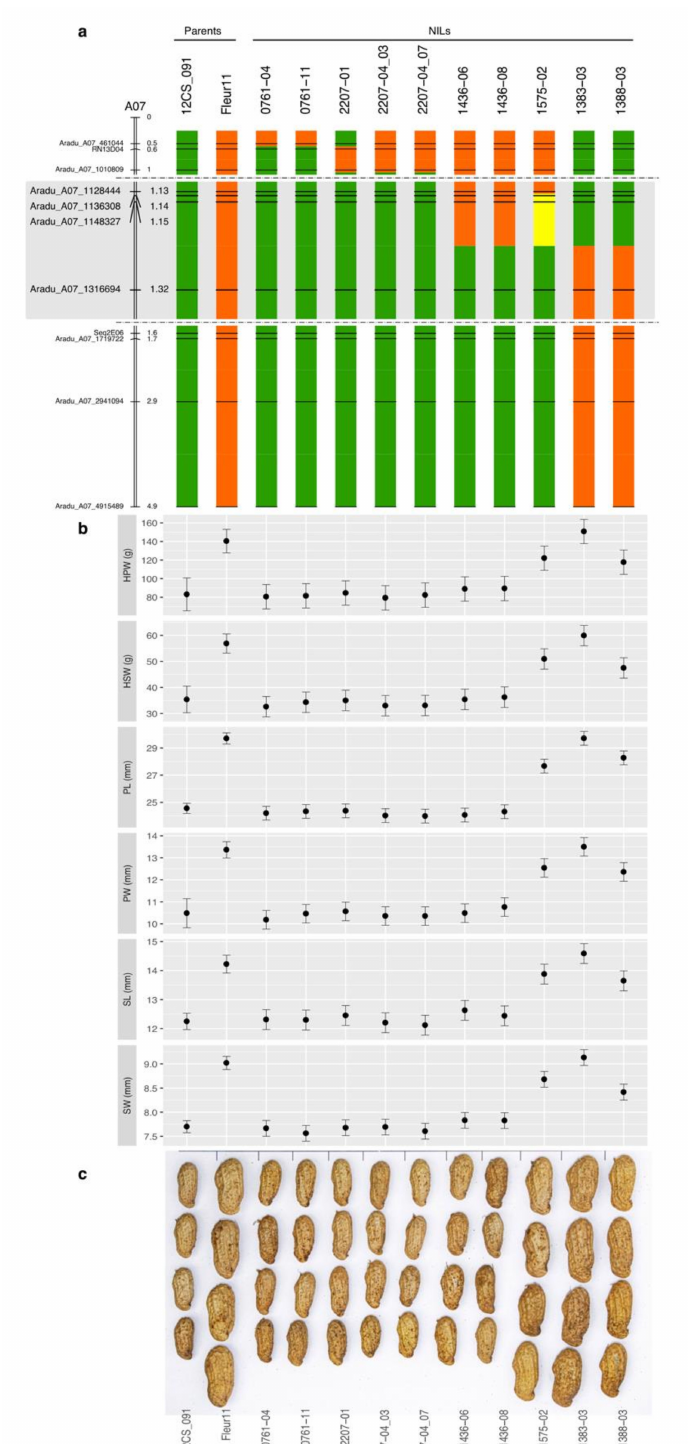
Figure 2. ( a ) Graphical genotypes of the NILs. The names and physical positions (in Mb) of the markers are shown on the left, and the names of NILs and parents at the top of the graph. Homozygous Fleur11 alleles are represented in orange and homozygous A. duranensis alleles in green. The region with an homeologous exchange between A and B genomes are represented in yellow. The two parents (Fleur11 and 12CS_091) are presented before NILs on the left. In order to reveal recombination points between very close markers, the vertical scale has been stretched in the region represented with a grey background. ( b ) Comparison of the mean values between the genotypes for the six measured traits. ( c ) Photography of harvested pods for the di ff erent NILs and their